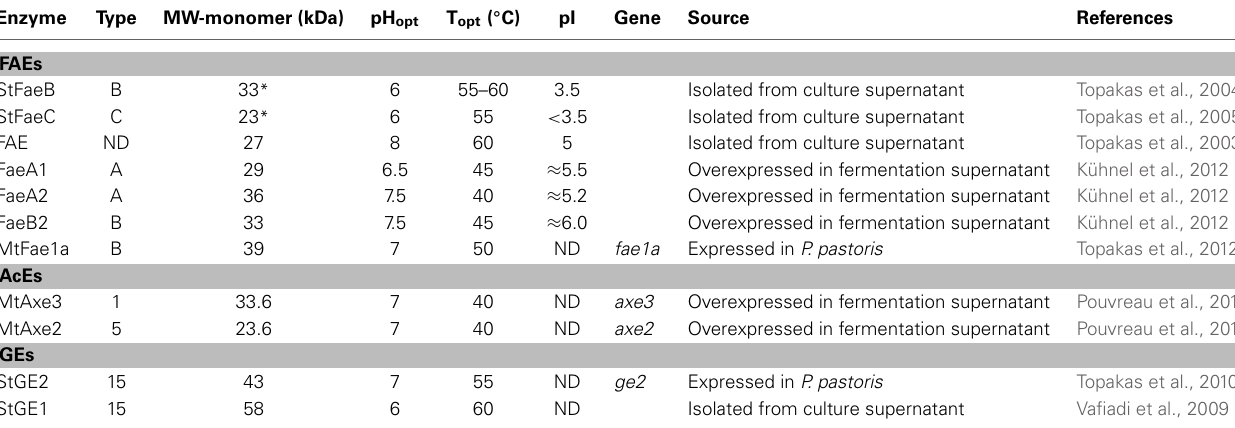
Table 8 | Description of M. thermophila characterized esterases (FAEs, AcEs, and GEs).